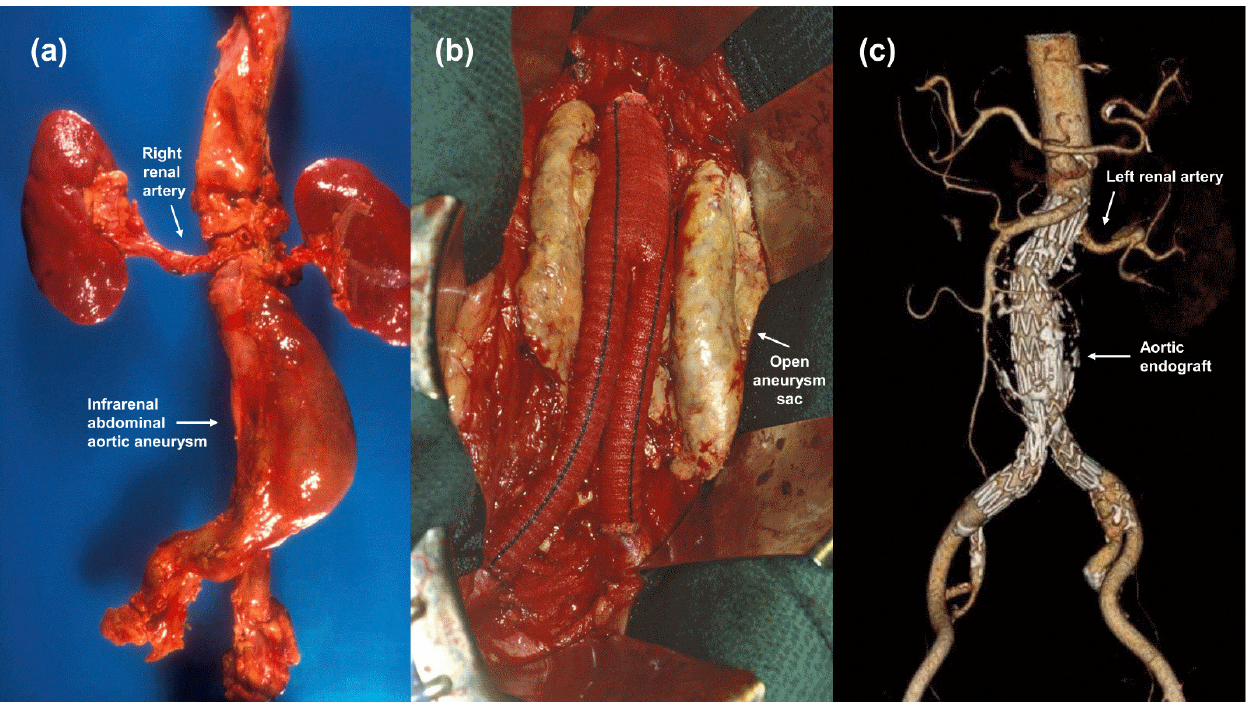
Figure 1. Images of infrarenal abdominal aortic aneurysms. ( a ) Autopsy specimen showing the relationship of an intact infrarenal aneurysm to the renal arteries. ( b ) Operative photograph during transabdominal open repair with a knitted bifurcation graft. ( c ) Three-dimensional computed tomogram after transfemoral endovascular repair in another